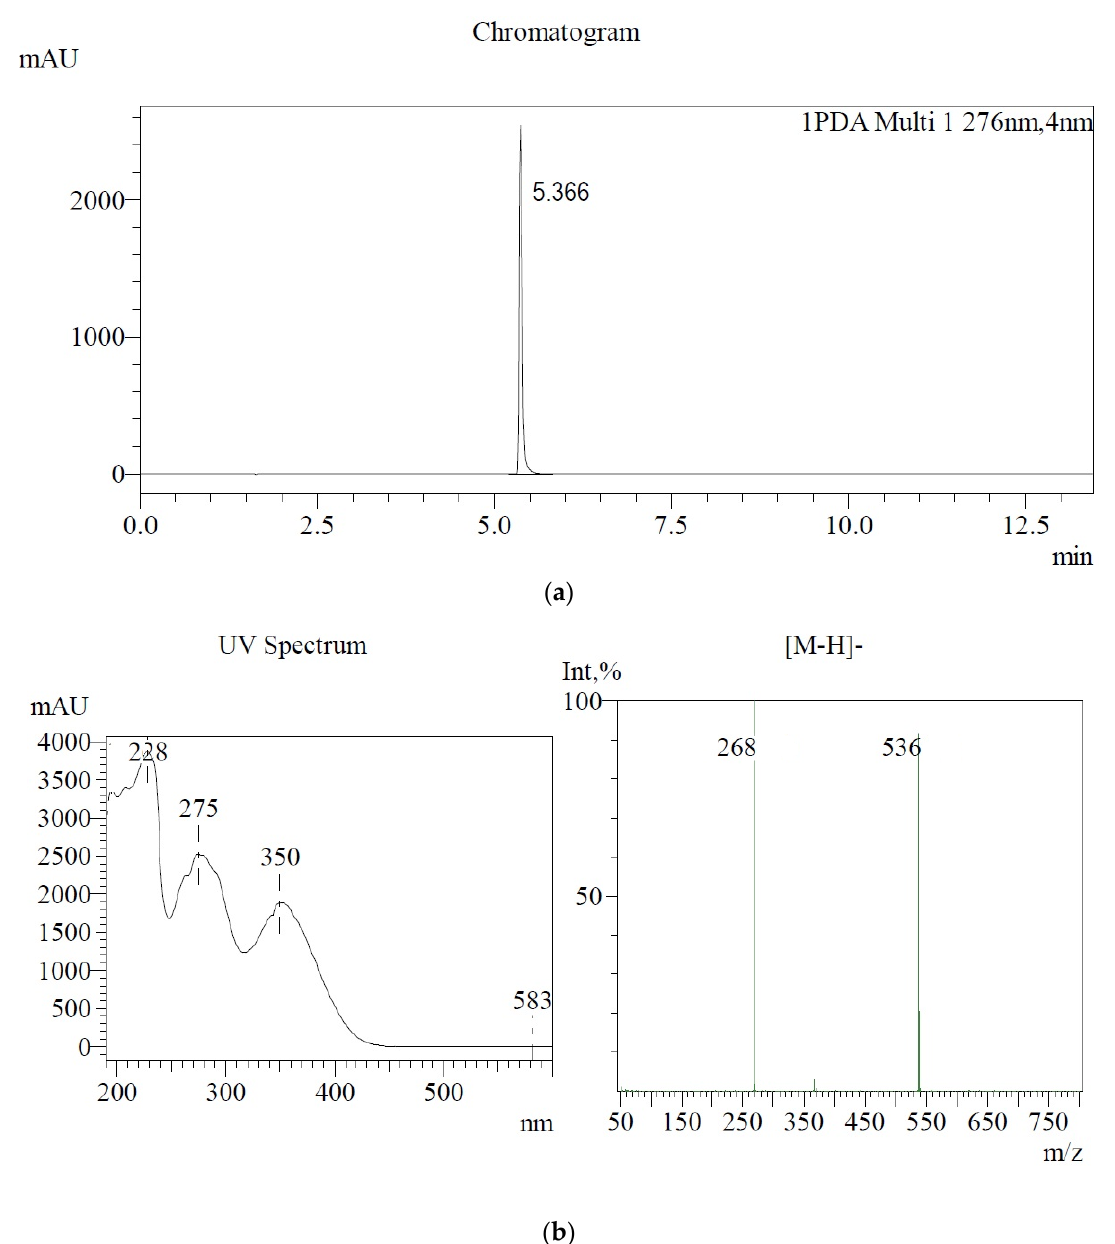
Figure 2. ( a , b ) LC-MS analysis data of TriNBO, obtained by nitration of 1,3-dihydro- 2H -benzimidazol-2-one.